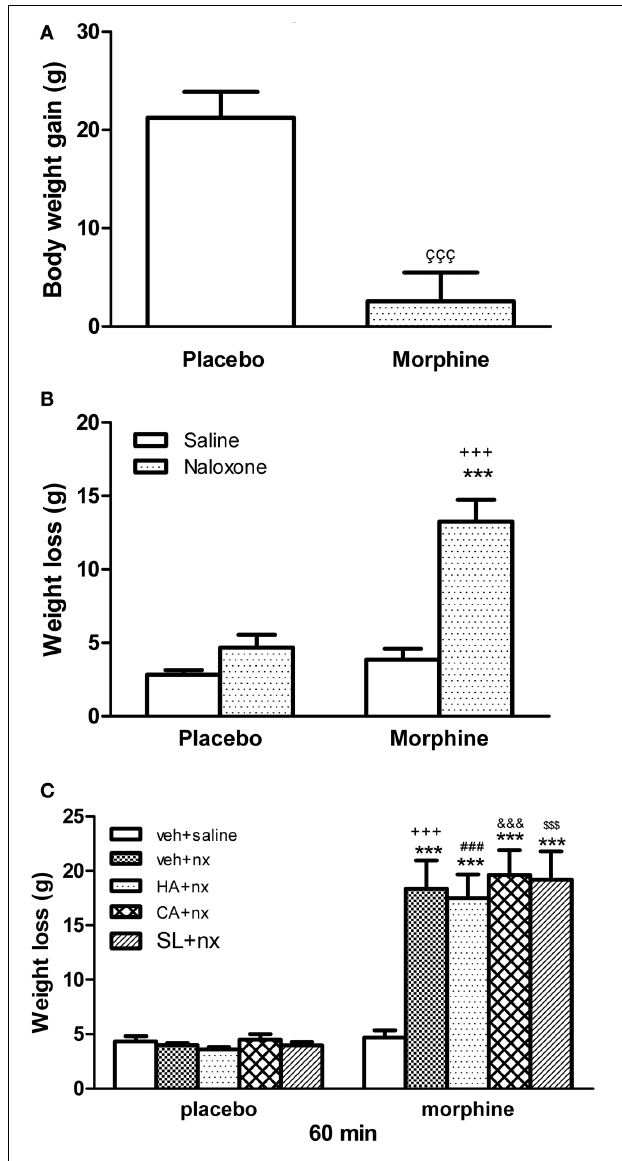
FIGURE 1 | (A) Effect or morphine pellet-implantation on body weight gain. (B) Body weight loss after naloxone-precipitated withdrawal. Animals received subcutaneous implantation of placebo or morphine pellets for 7 days. On day 8, rats were injected with saline or naloxone (nx, 2mg/kg) and decapitated 60min later. (C) Other groups of animals were pretreated with vehicle (veh), HA-1004 (HA, 40nmol/day), calphostin C (CA, 40pmol/day) or SL-327 (SL, 100mg/kg i.p.). Data are the mean ± s.e.m. ççç p < 0 . 001 vs. placebo; ∗∗∗ p < 0 . 001 vs. morphine-dependent group receiving saline instead of naloxone; +++ p < 0 . 001 vs. the control group injected with naloxone; ### p < 0 . 001 vs. placebo + HA + nx; &&& p < 0 . 01 vs. placebo + CA + nx; $$$ p < 0 . 001 vs. placebo + SL +